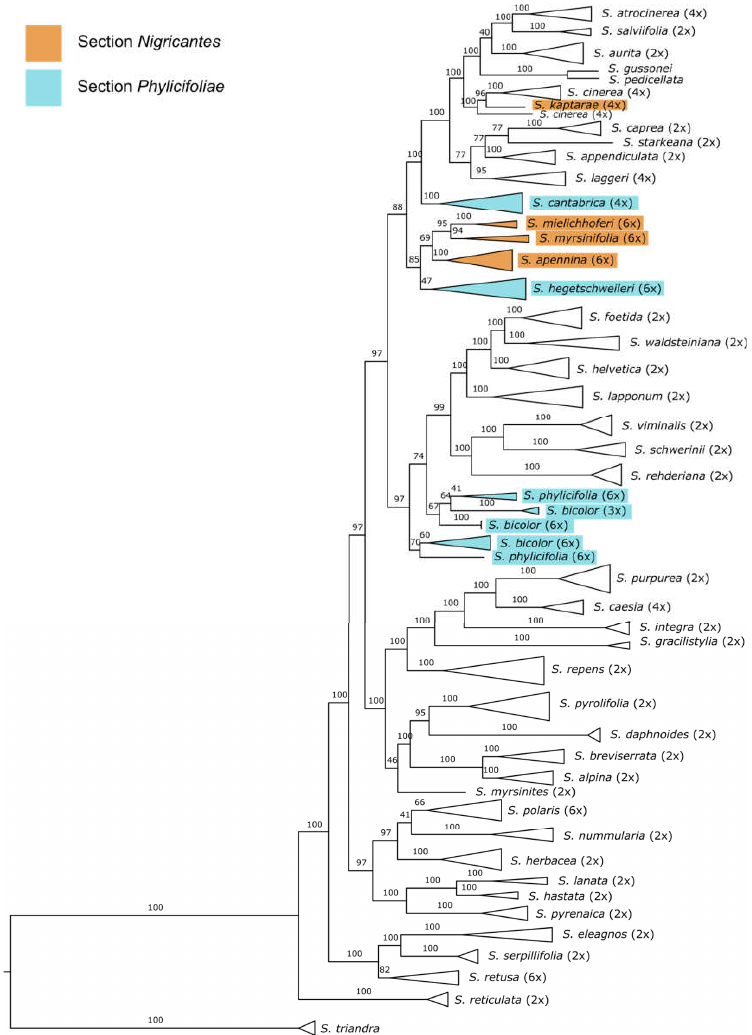
Figure 2. Backbone topology of the Chamaetia/Vetrix clade including 145 samples representing 45 Eurasian species plus S. triandra as outgroup based on a RAxML analyses on 46,568 RAD loci (630,764 SNPs) in a concatenated alignment of 5,341,180 bp and 66.95% missing sites. Bootstrap support values above branches. Ploidy level of species behind the species names. Species of the sections Nigricantes and Phylicifoliae are displayed in colors according to the legend. (Additional quartet sampling scores are displayed in Supplementary Figure S1).